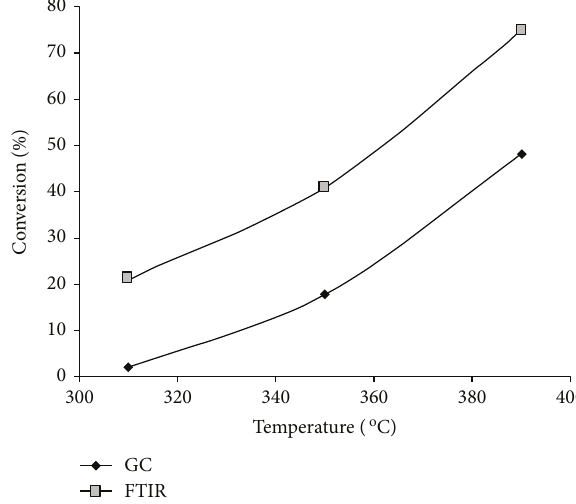
Figure 6: Comparative maximum conversion and hydrotreated samples by FTIR and CG/MSD at di ff erent temperatures with catalyst 0.01% Pt and 20% USY/Al